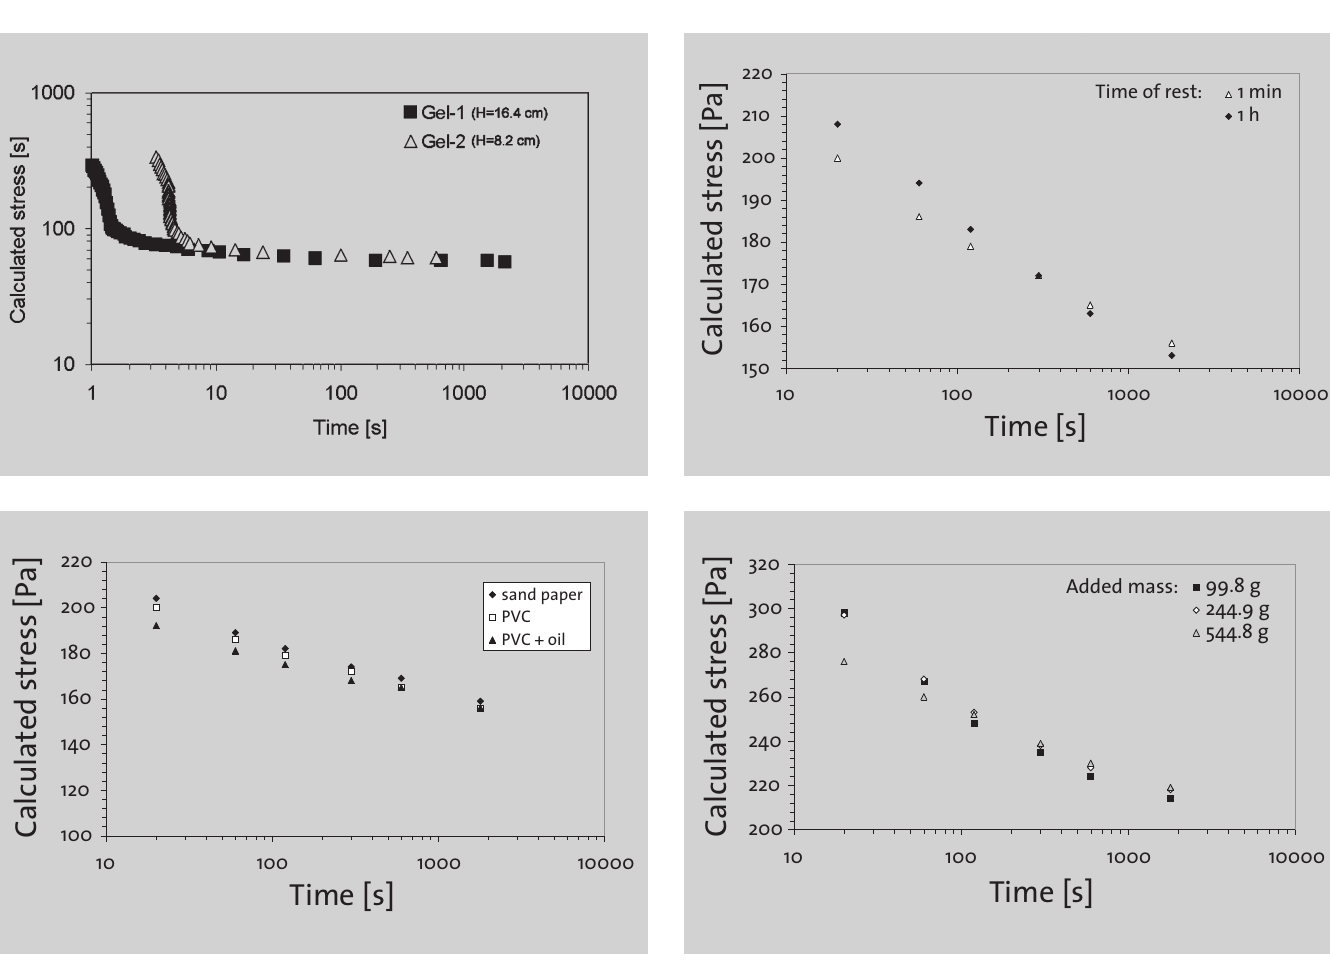
Figure 4 (left above): Calculated stress (see text) from slump test as a function of time with hair gel for two different initial heights (cf. Figure 3). Figure 5 (right above): Calculated stress from slump test as a function of time for a sewage sludge after different times of preliminary rest. Figure 6 (left below): Calculated stress from slump test as a function of time for a sewage sludge with different bottom surfaces. Figure 7 (right below): Calculated stress from slump test as a function of time for a sewage sludge when using different additional